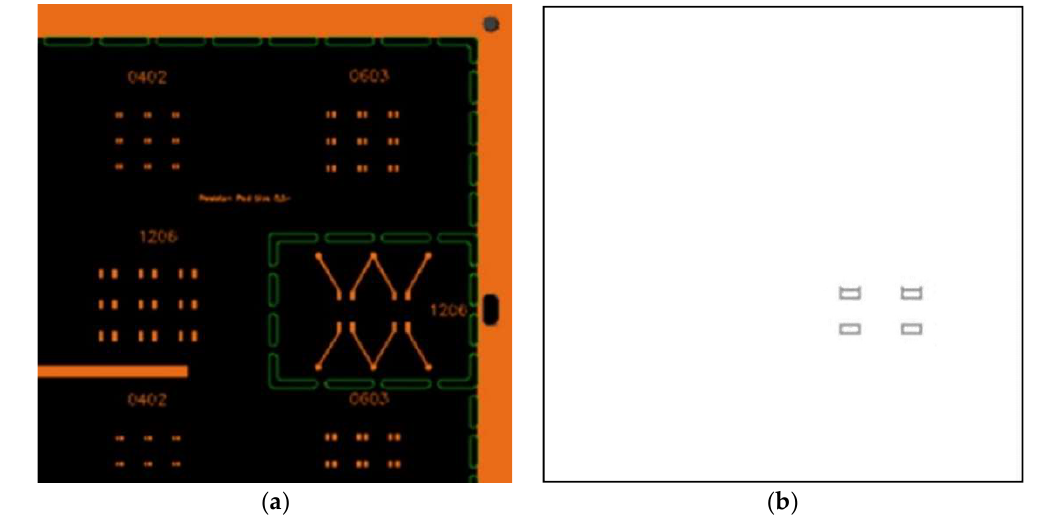
Figure 2. Prototype 1 board layout ( a ) and stencil design ( b ).